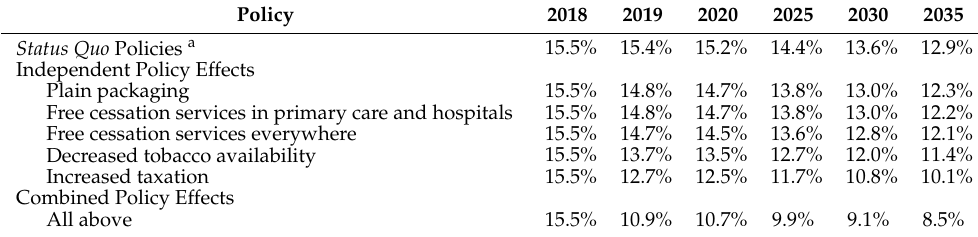
Table 1. SimSmoke Model Predicted Smoking Prevalence, for Both Sexes, Ages 15–85, With and Without Tobacco Endgame Policies, Ontario, 2018–2035.